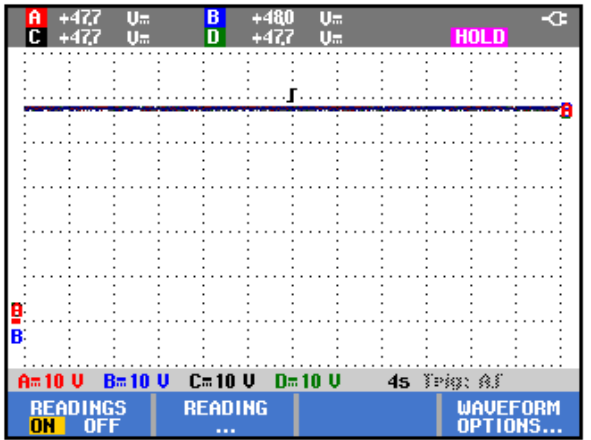
Figure 19. DGUs voltages during mixed voltage attacks.